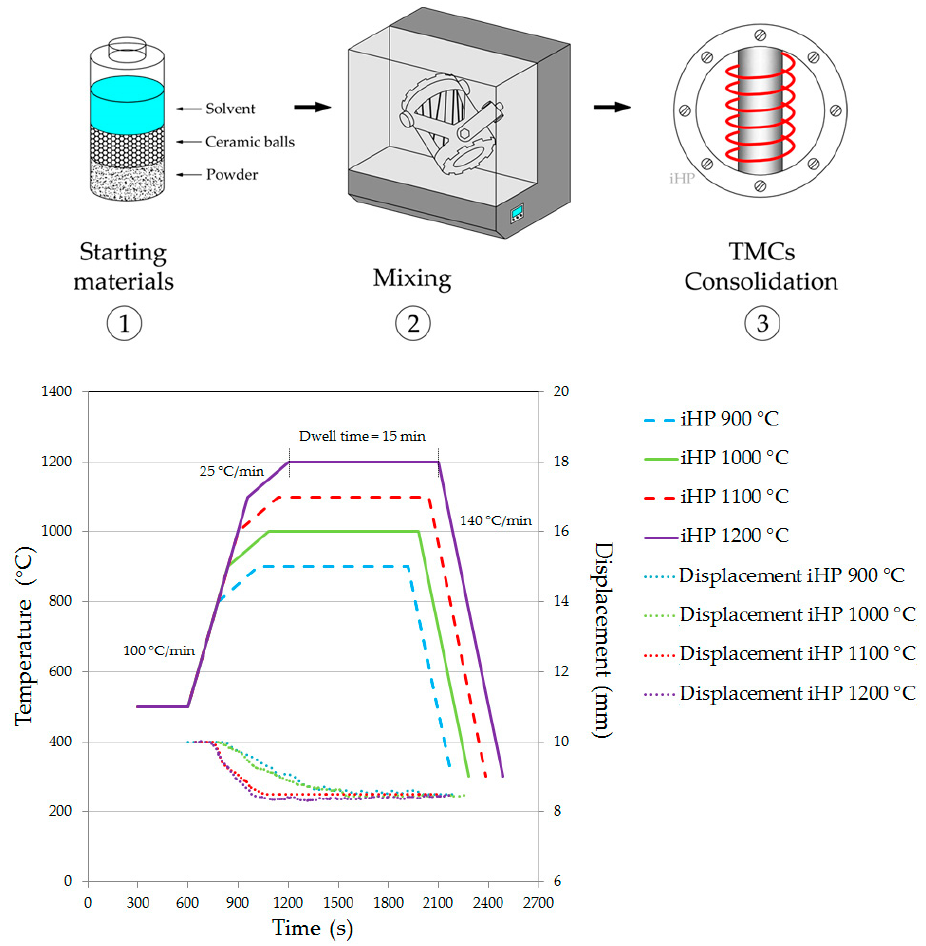
Figure 2. Sketch of the manufacturing process of the TMCs.